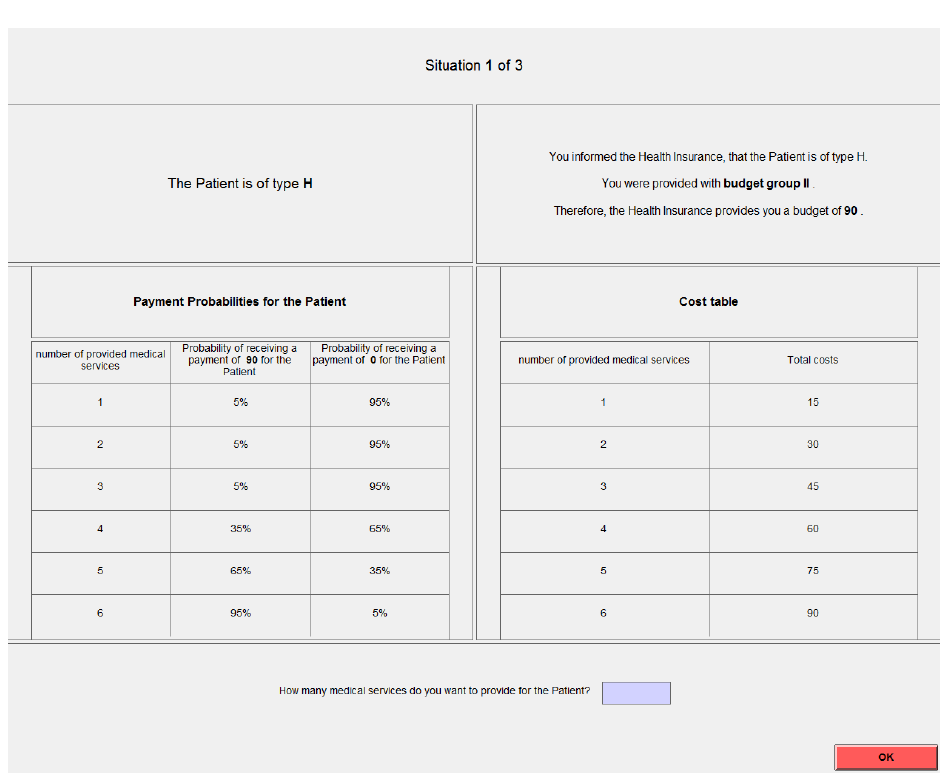
Figure A2. Reporting stage.